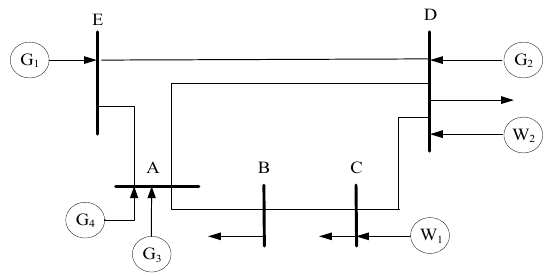
Figure 5. Topology of the five bus system. Table 2. Parameters of the generator.